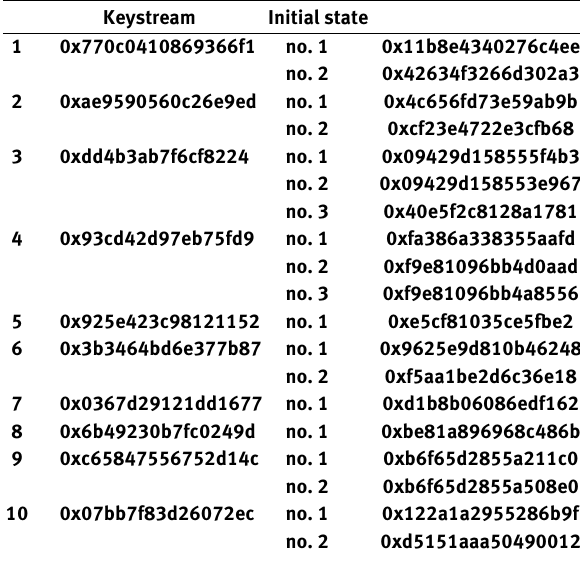
Table 2: The solutions found for 10 cryptanalysis instances of the A5/1 generator (in hexadecimal